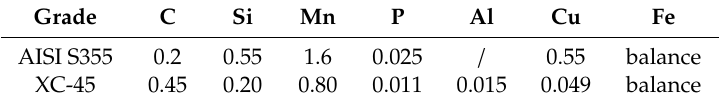
Table 1. Chemical composition of the base plate and the welding wire